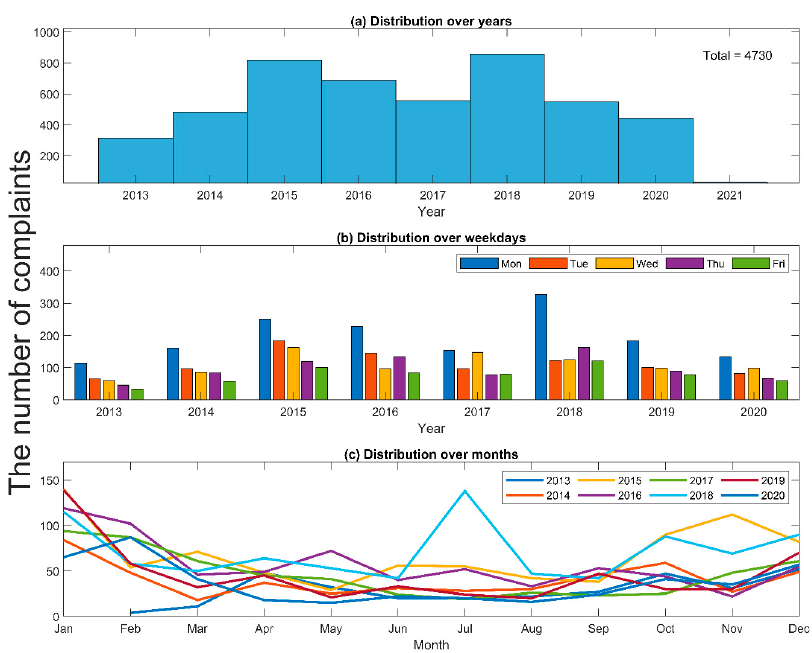
Figure 3. Basic statistics for customer complaints at WBG, including ( a ) the number of customer complaints received per year, ( b ) the total number of customer complaints on each day of the week, and ( c ) the total number of complaints in each month of the year. Complaints were received between February 2013 and January 2021, so the year 2021 shows a small number of complaints.